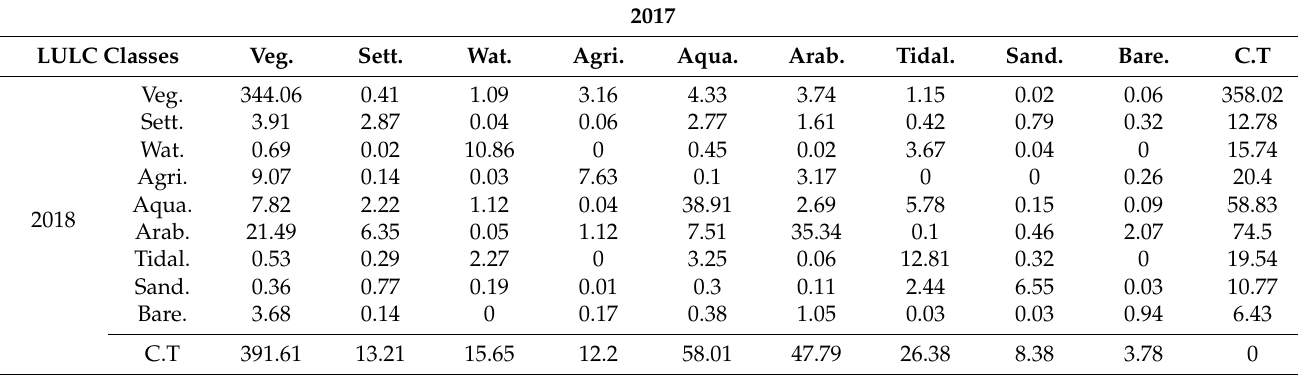
Table A3. Spatiotemporal transition of LULC, Ukhiya-Teknaf, 2017–2018 (in km 2 ), here, Veg. = vegetative, Sett. = Settlement, Wat. = Water-body, Agri. = Agricultural land, Aqua. = Aquaculture land, Arab. = Arable land, Tidal. = Tidal Mudflat, Sand. = Sandy area, Bare. = Bare